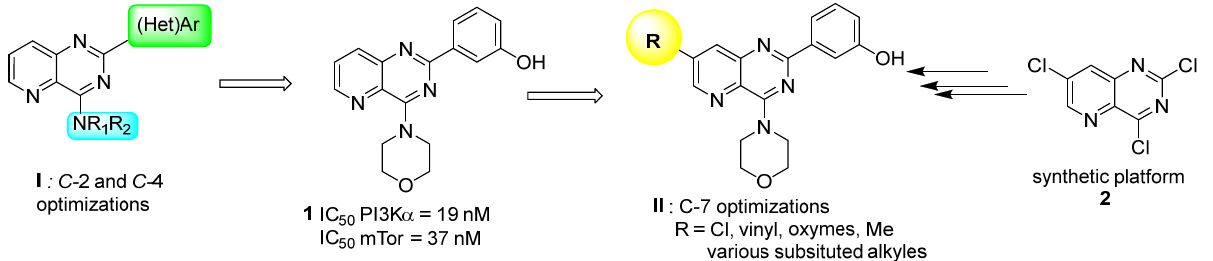
Figure 2. Modulations of C-7 position in the pyrido [3.2- d ]pyrimidine series.